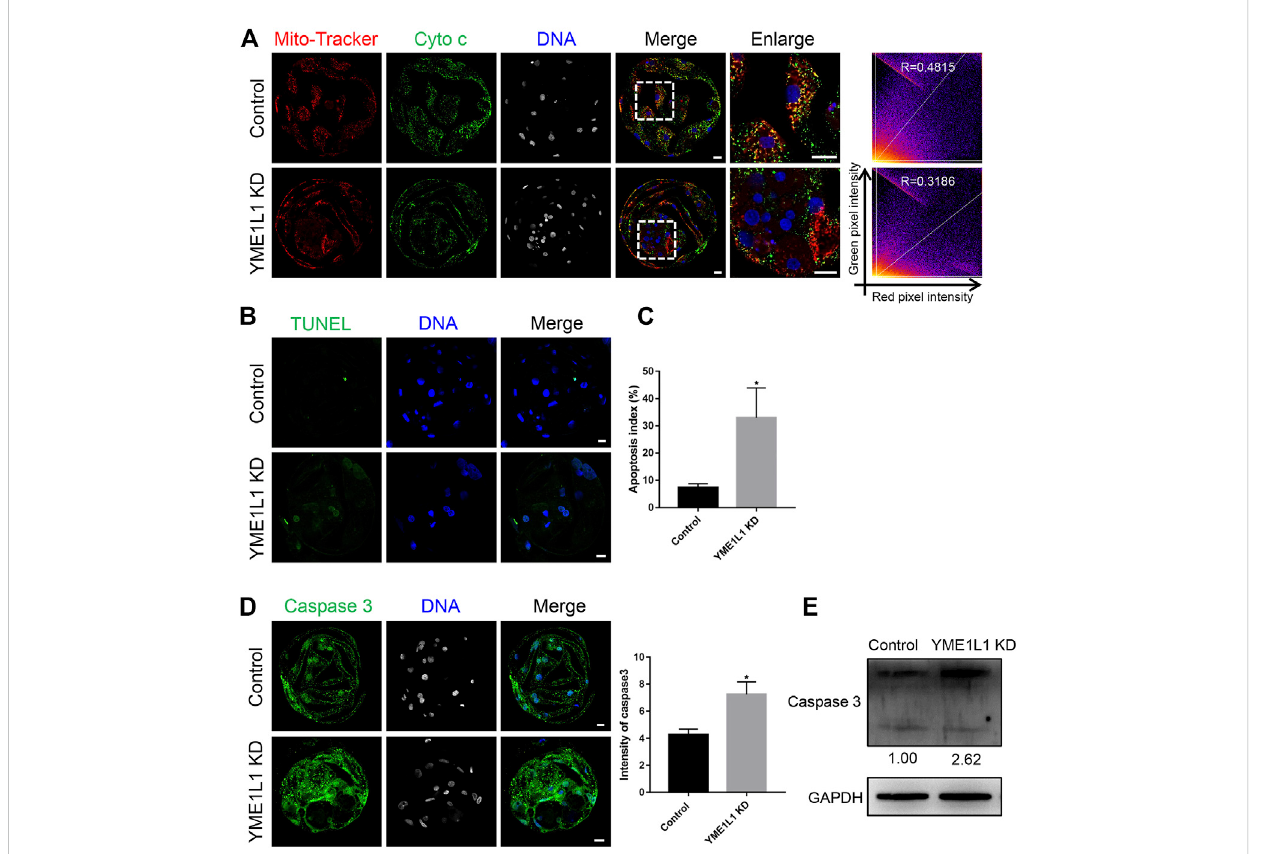
FIGURE 5 Knock-down of YME1L1 induces apoptosis in porcine embryos. (A) Representative images of blastocysts showed cytochrome c and MitoTracker Red staining in control and YME1L1 KD group. Scale bars, 20 μ m. (B, C) TUNEL assay and apoptosis index at blastocyst stage in control and YME1L1 KD group. (D) Representative images of Control and YME1L1 KD blastocysts showed activated caspase 3 expression and relative intensity. Scale bars, 20 μ m. (E) Western blotting of blastocysts in Control and YME1L1 KD group showing activated caspase 3 expression. * p < 0.05 indicate signi fi cant differences between treatment